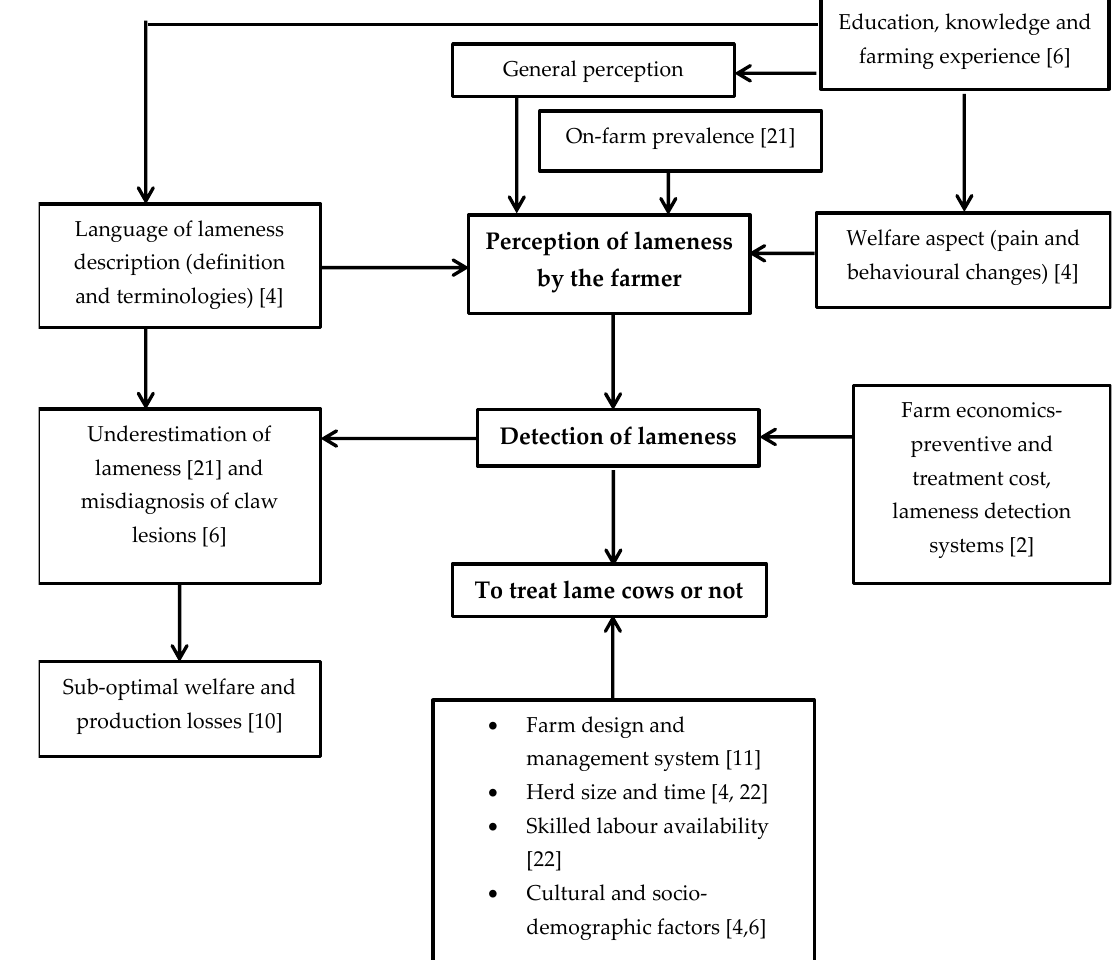
Scheme 1. Schematic diagram showing the factors and events linked to farmers’ perception of lameness, detection and decision-making on the treatment of lame cows. (Developed based on the associations presented by Dolecheck et al. [2], Leach et al. [4], Olmos et al. [6], van De Gutch et al. [11], Bran et al. [21] and Becker et al.